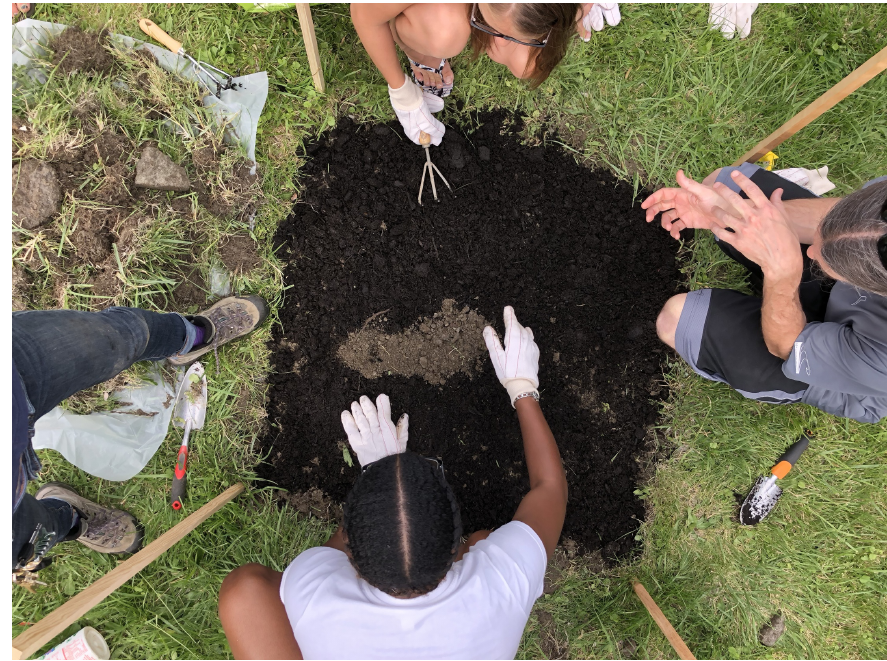
Figure 5: Participants preparing a plot for the Lawn (Re)Disturbance Laboratory as part of a workshop with Community Miracles in Action and the Sanctuary for Independent Media’s NATURE Lab, Cohoes, New York, June